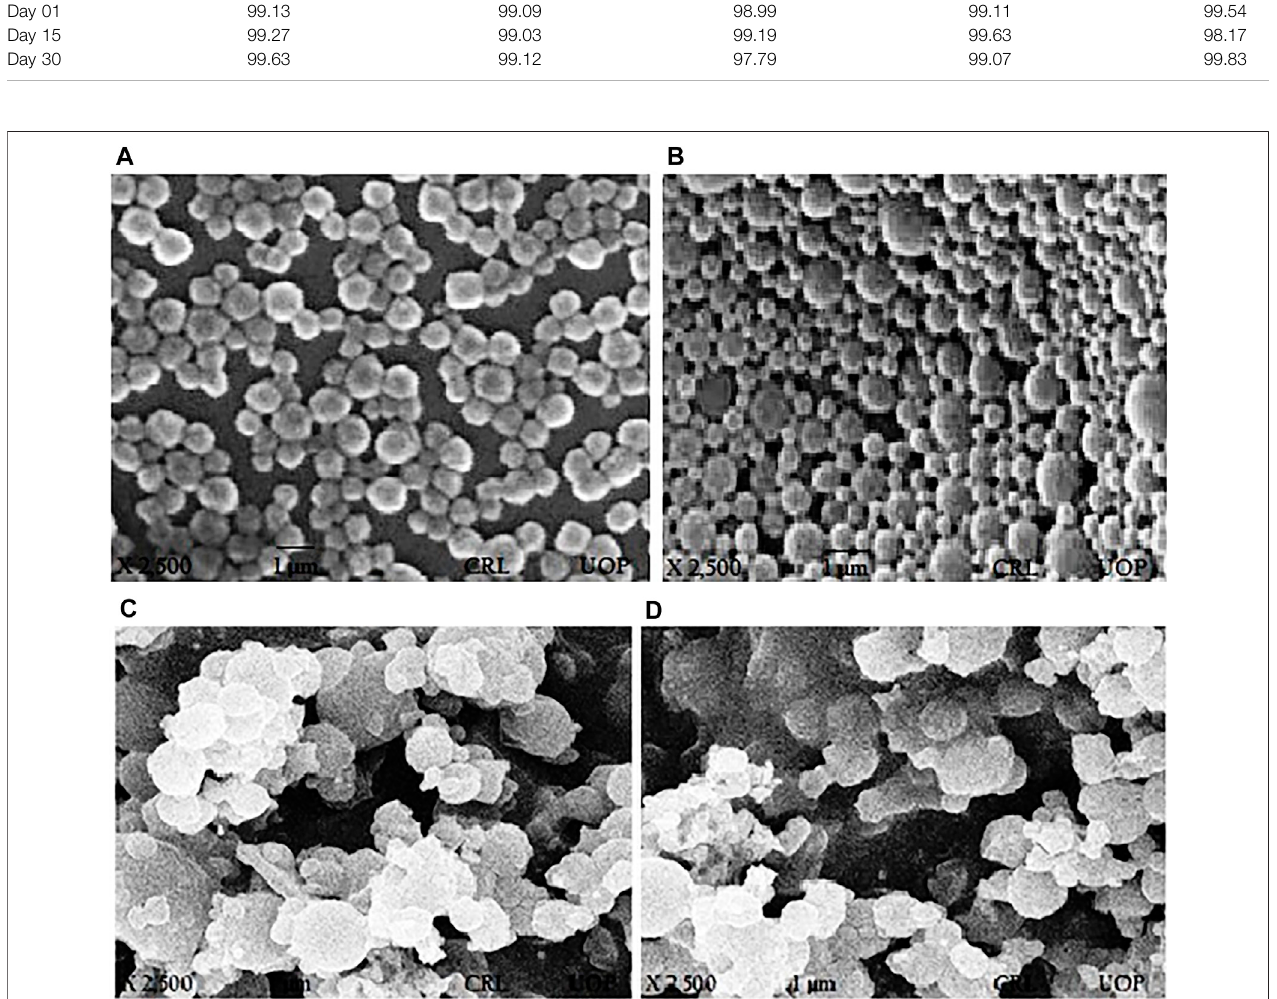
FIGURE 2 | SEM images of paclitaxel-loaded PLGA nanoformulations with poloxamer 407. (A) PTX 108, (B) PTX 112, (C) PTX 108ab, and (D) PTX 112ab.